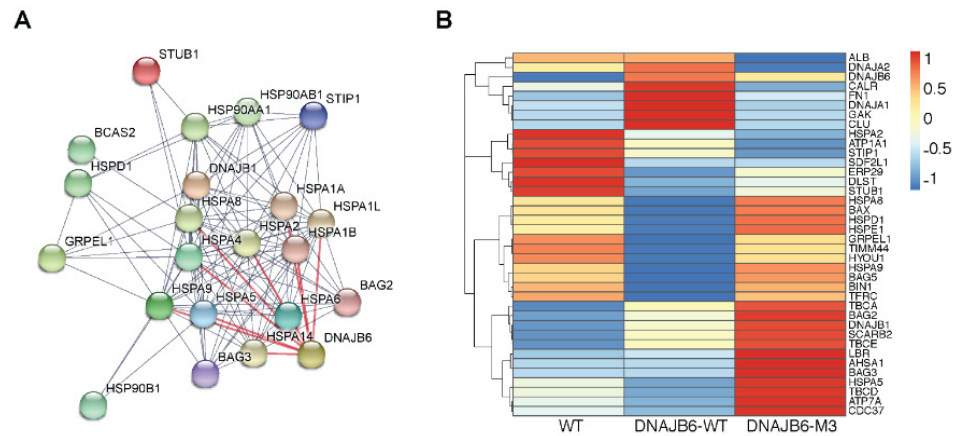
Figure 6. Comparative analysis of chaperones among WT, DNAJB6-WT, and DNAJB6-M3 EVs. ( A ) Predicted interacting partners of DNAJB6 and their interactions using STRING database. ( B ) Heatmap of row-scaled intensity values of proteins involved in protein folding found in WT, DNAJB6-WT, and DNAJB6-M3 EVs.